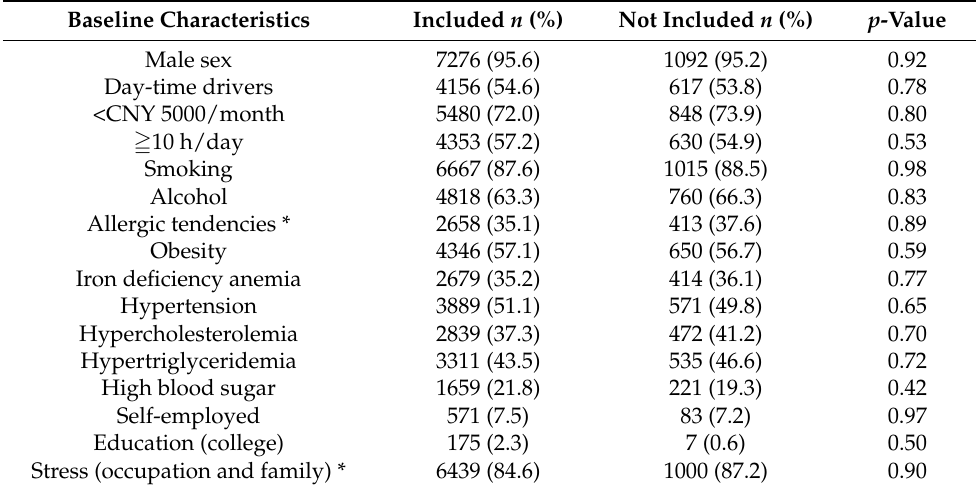
Table 1. Baseline characteristics of taxi drivers included ( n = 7611) and not included ( n = 1147). Baseline Characteristics Included n